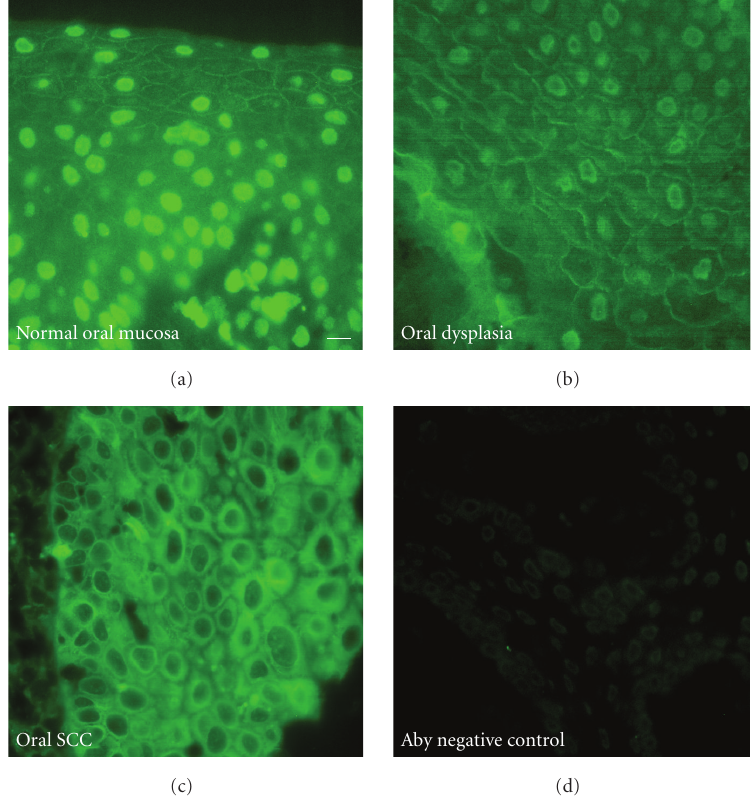
Figure 3: Representative antiplakophilin-1 staining of oral tissues. Antiplakophilin-1 monoclonal antibody (14B11) was used to stain normal oral mucosa (a), dysplastic oral mucosa (b), and oral squamous cell carcinoma (c). Normal oral mucosa processed in the absence of primary antibody serves as a negative control (d). The scale bar in panel A corresponds to 20 μ